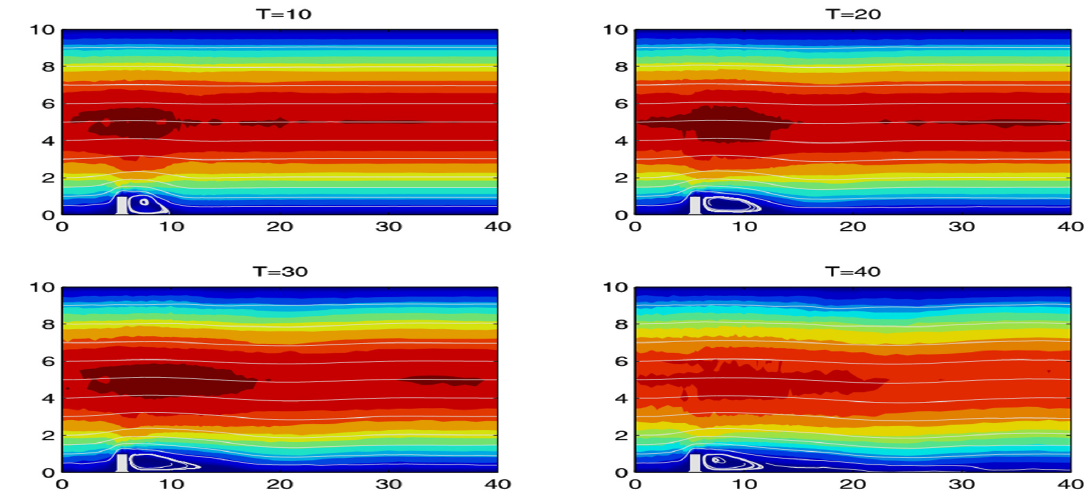
Figure 5. Four snapshots ( t = 10,20,30, and 40) of the nonlinear TRM with deconvolution order N = 0, filter length δ = 0.5, and relaxation term χ = 3.0. Shown are streamlines overlaid above speed contours | v ( x , t ) | . This figure was originally published in [11]. h